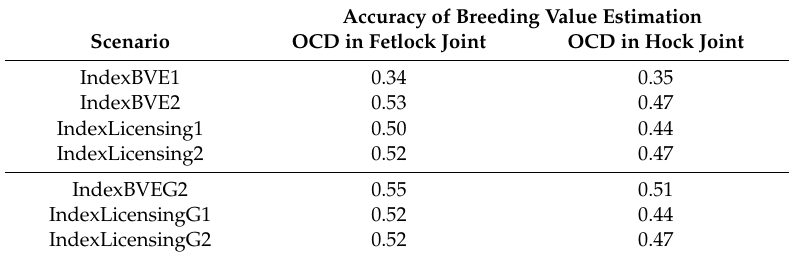
Figure 4. Proportion of unselected offspring with OCD in fetlock joints and hock joints for two reference scenarios and for four different scenarios including OCD in the breeding value estimation and in a selection index at the stage of stallion licensing.